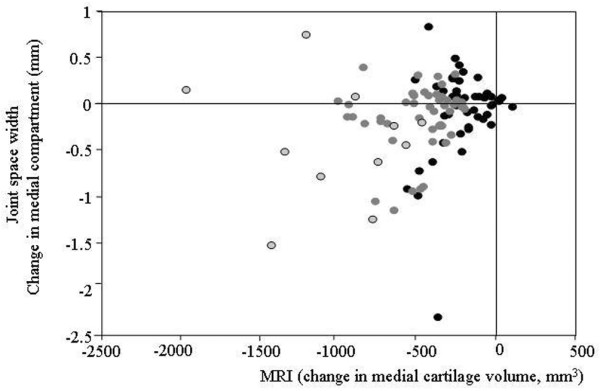
Scatter plot contrasting the changes in the medial compartment cartilage volume versus minimum joint space width measured by standardized radiograph at 24 months for 107 OA patients. Subgroups of slow (black), intermediate (dark gray), and fast (light gray) progressors are identified. No correlation between the cartilage volume and the minimum joint space width was found.